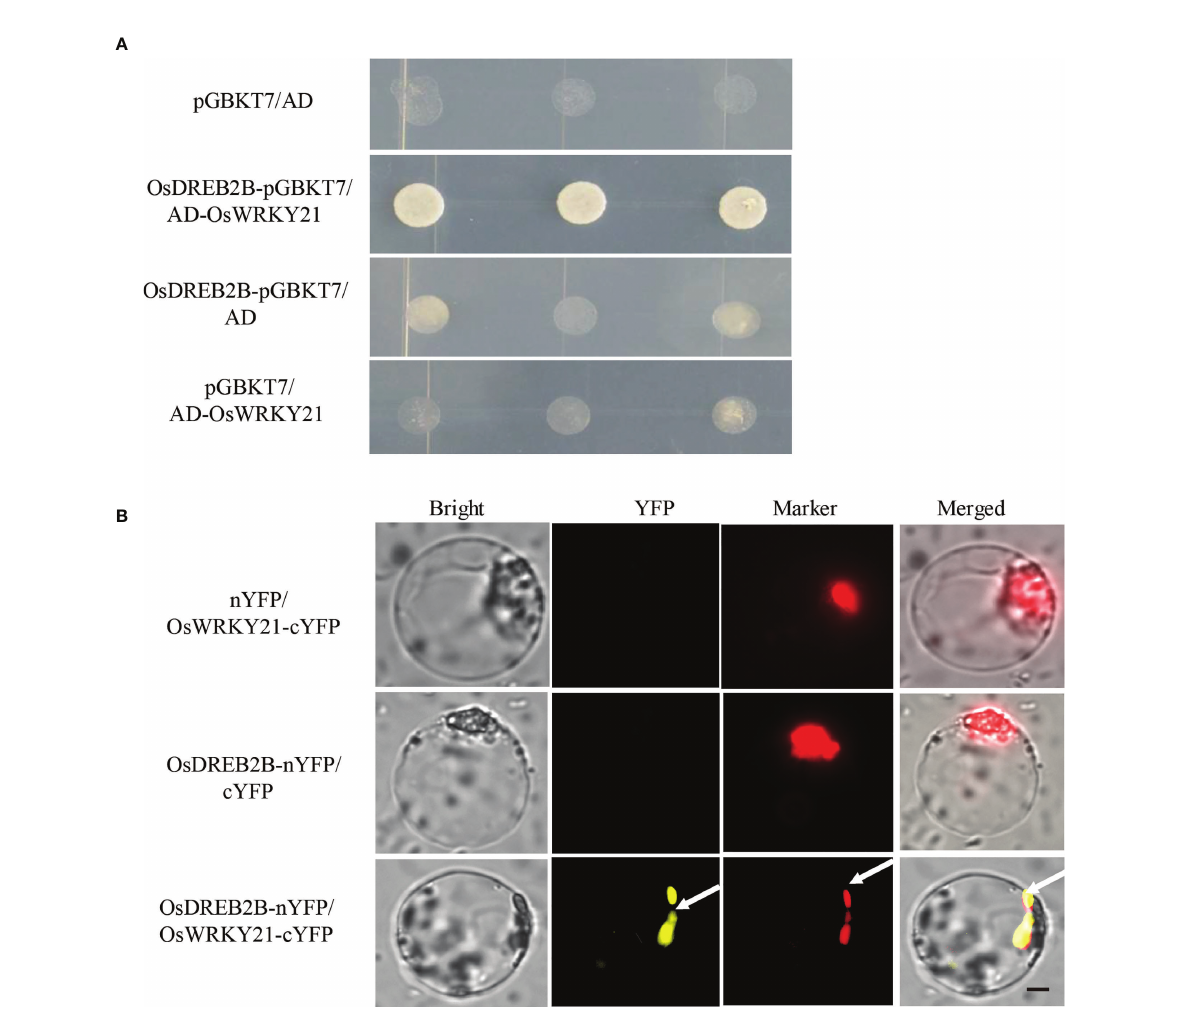
FIGURE 9 OsDREB2B physically interacts with OsWRKY21 in yeast and plant cells. (A) The interaction of OsDREB2B and OsWRKY21 was detected in yeast cells. AD, activation domain; BD, GAL4-DNA binding domain. (B) BiFC was used to detect the interaction of OsDREB2B and OsWRKY21 in rice protoplasts. Bright, bright fi eld; YFP, YFP fl uorescence; Marker, marker fl uorescence. Bar = 10